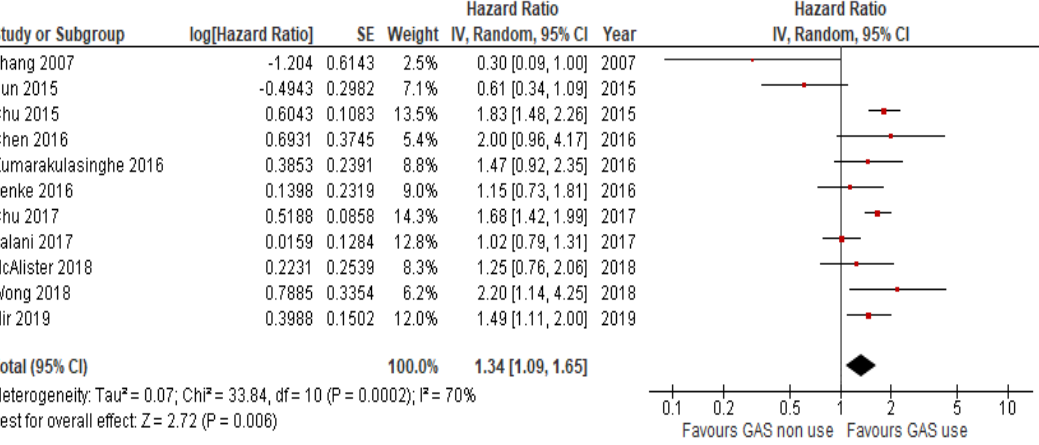
Figure 3. Forest plot for progression free survival of the analyzed studies. 2.2. Subgroup Analysis